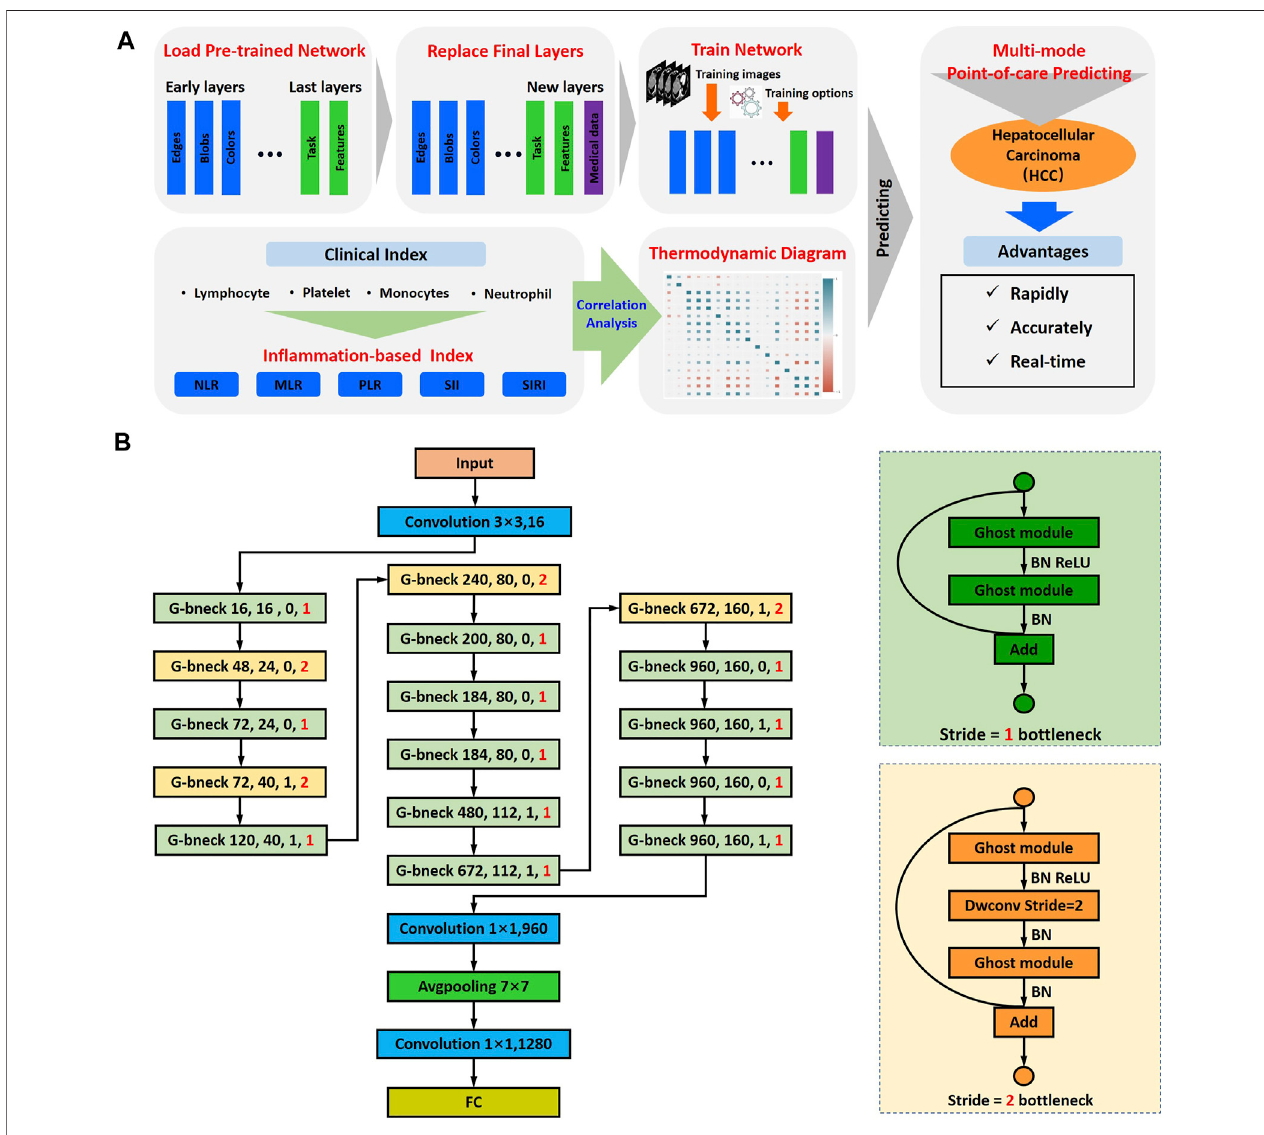
FIGURE 1 | Schematic of multi-modal point-of-care predicting system. (A) Schematic of point-of-care system to predicting the response of TACE in HCC by integrating multi-modal large-scale CT imaging and clinical evaluation indexes. (B) The architecture of GhostNet and deep learning model fl owchart.